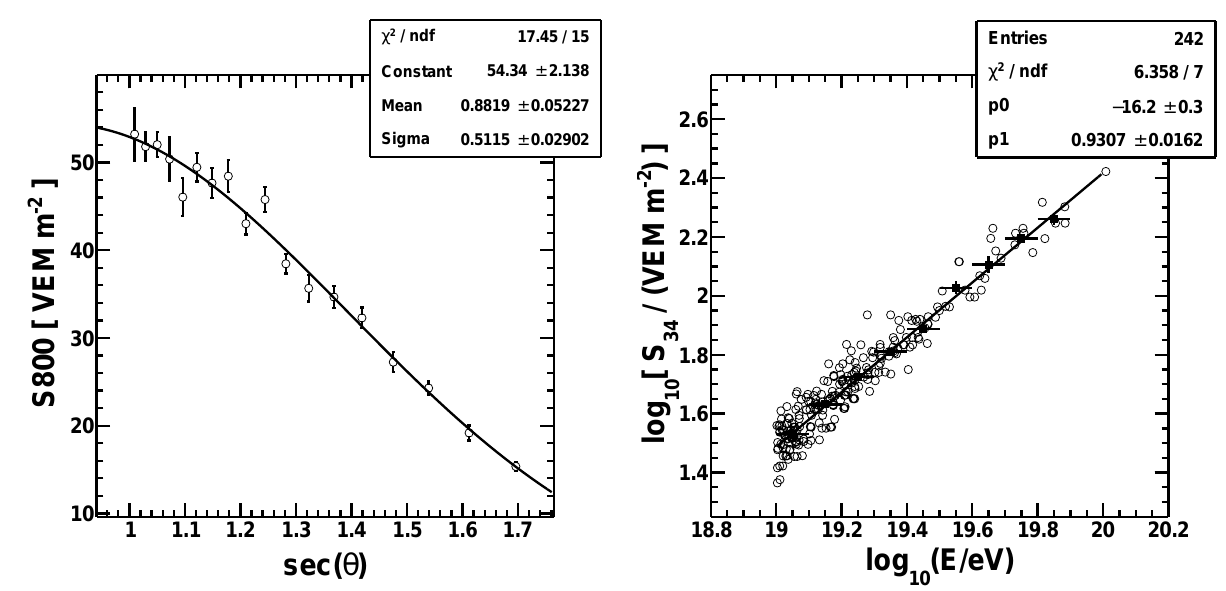
Figure 5. (LEFT): Minimum cuts on S800 that maintain a constant number of events in the equal-intensity angular bins for the TA SD data, plotted versus secant of the event zenith angle ( θ ). Solid line represents a fit to a Gaussian. Since the mean zenith angle of this data set is 34 ◦ , we choose to normalize the Constant Intensity Cut Curve (CIC) so that it is unity at sec(34 ◦ ). We define S 34 = S800 / CIC(sec( θ )) to be the estimator of the shower energy ( E ). Physically, S 34 represents the S800 of a shower of the same energy E but arriving at a zenith angle of 34 ◦ instead of θ . (RIGHT): Logarithm of the energy estimator S 34 plotted versus the logarithm of the energy for well reconstructed events that have been seen by both SD and FD. Open circles show the individual hybrid events, solid circles show the mean values of log ( S 34 ) in the log ( E ) bins, and the solid line represents the linear fit. 10 10